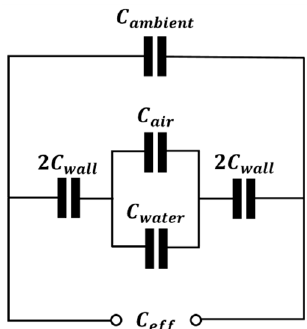
Figure 3. Equivalent circuit representation of helical capacitance sensor.